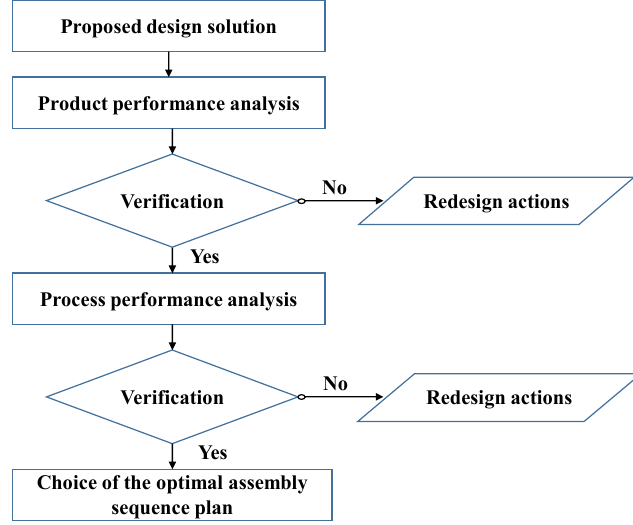
Figure 8. Analysis methodology for the choice of the appropriate assembly sequence.